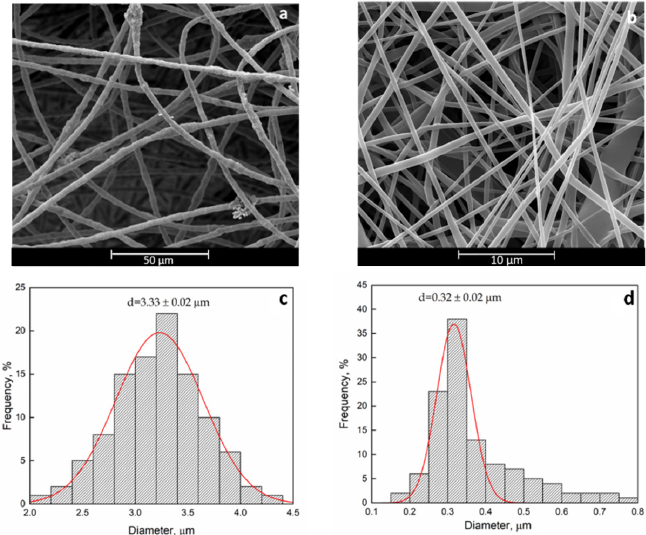
Figure 1. SEM and fiber diameter distribution of pristine Poly(3-hydroxybutyrate) (PHB) ( a , c ) and pristine poly( ε -caprolactone) (PCL) ( b , d ).